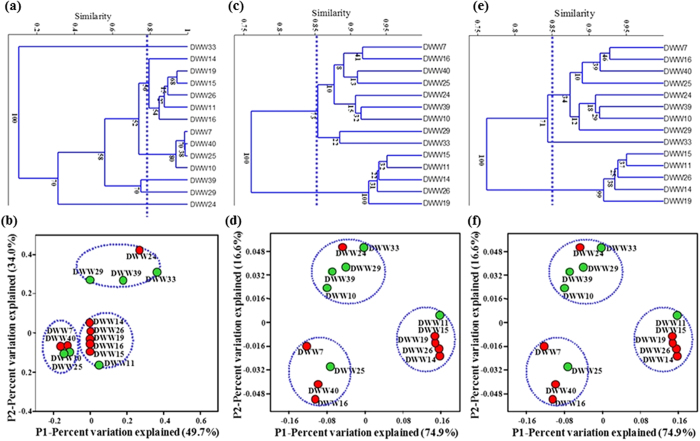
Cluster and principle coordinate analysis of 14 DWW samples.Cluster analysis are shown at phylum level (a), at the class level (c), and at the genus level (e). The analysis is conducted using the unweighted pair group mean averages (UPGMA) based on the Bray-Curtis distance. Dotted lines show the similarity cutoff level to cluster and group 14 DWW samples. The principle coordinate analysis are shown at phylum level (b), at the class level (d), and at the genus level (f). Filled red circles represent samples with high MeHg and green circles represent samples with high tHg and low MeHg levels. Note different x axis scales.